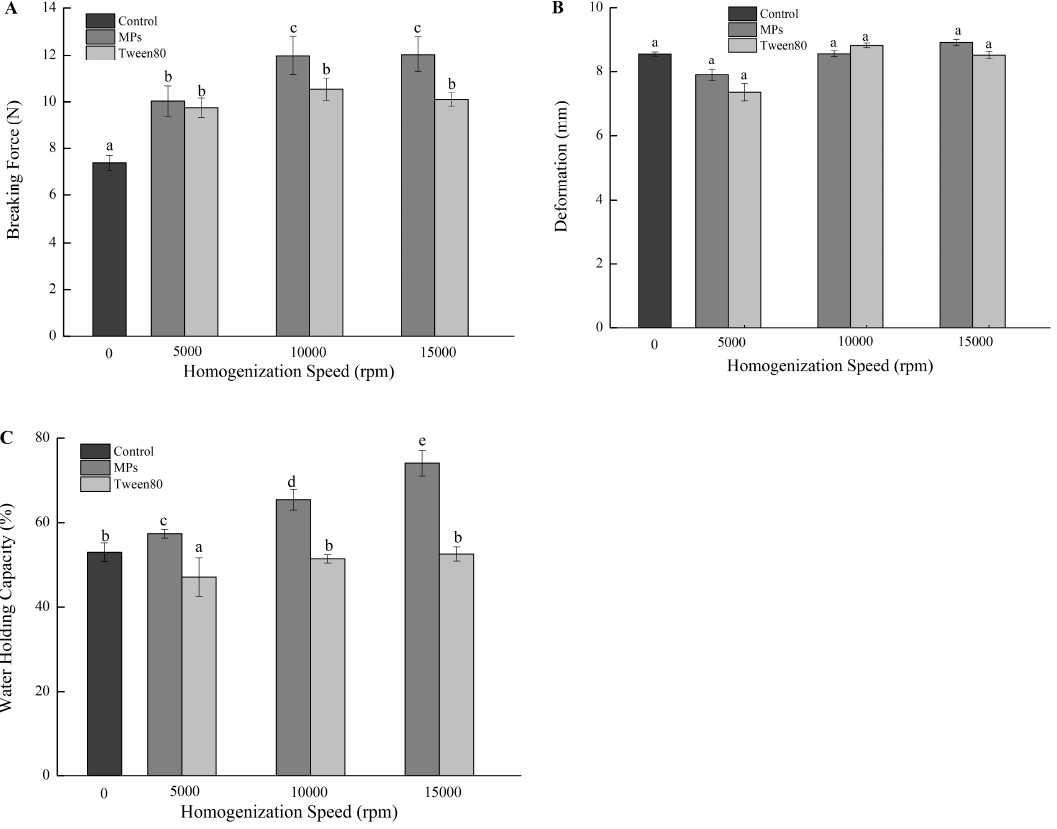
Figure 2. Breaking force ( A ), deformation ( B ), and the water-holding capacity ( C ) of gels containing MP- or Tween 80-stabilized camellia seed oil emulsions. Bars represent the standard deviation ( n = 3). Different letters above bars indicate significant differences ( p < 0.05).